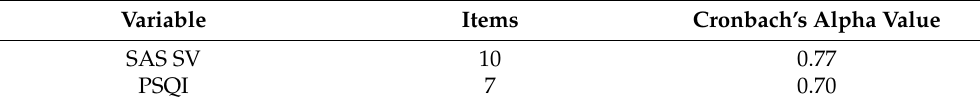
Table 6. Reliability test of two